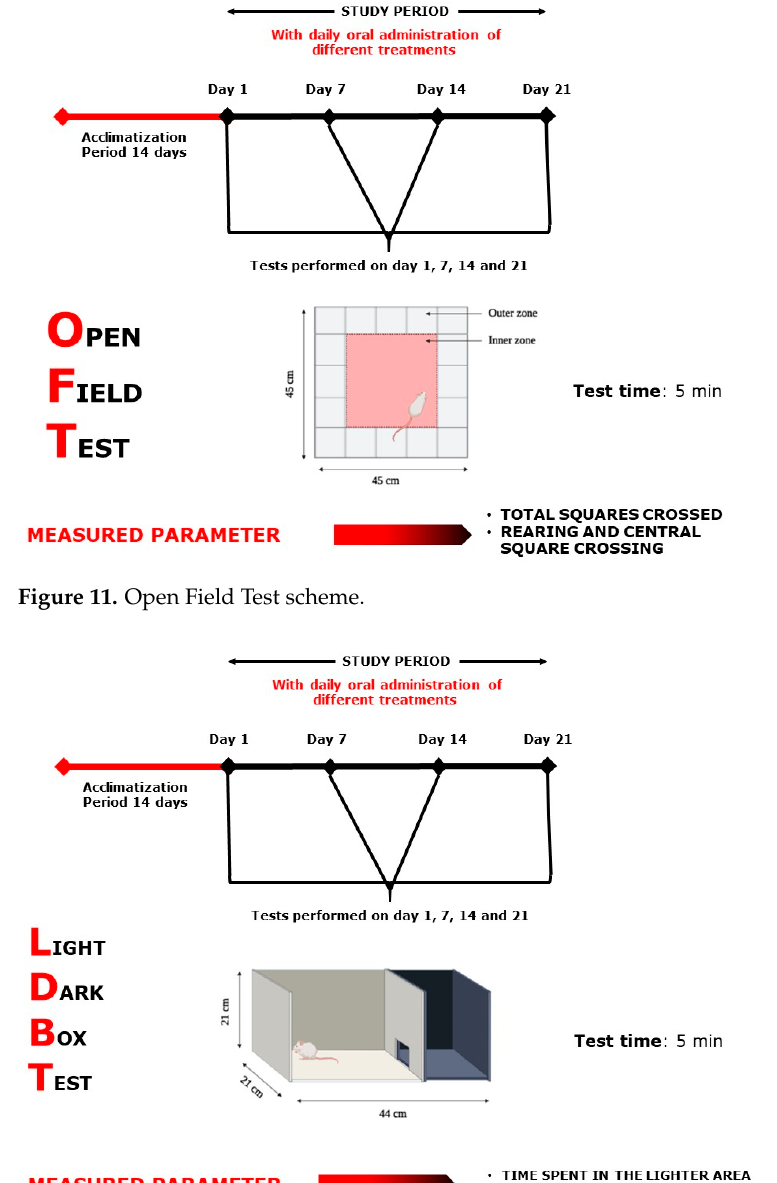
Figure 12. Light–Dark Box Test scheme.